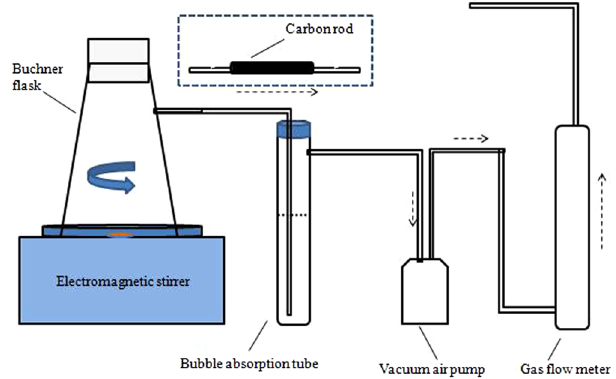
Figure 8. Experimental device of sludge treatment and odorous